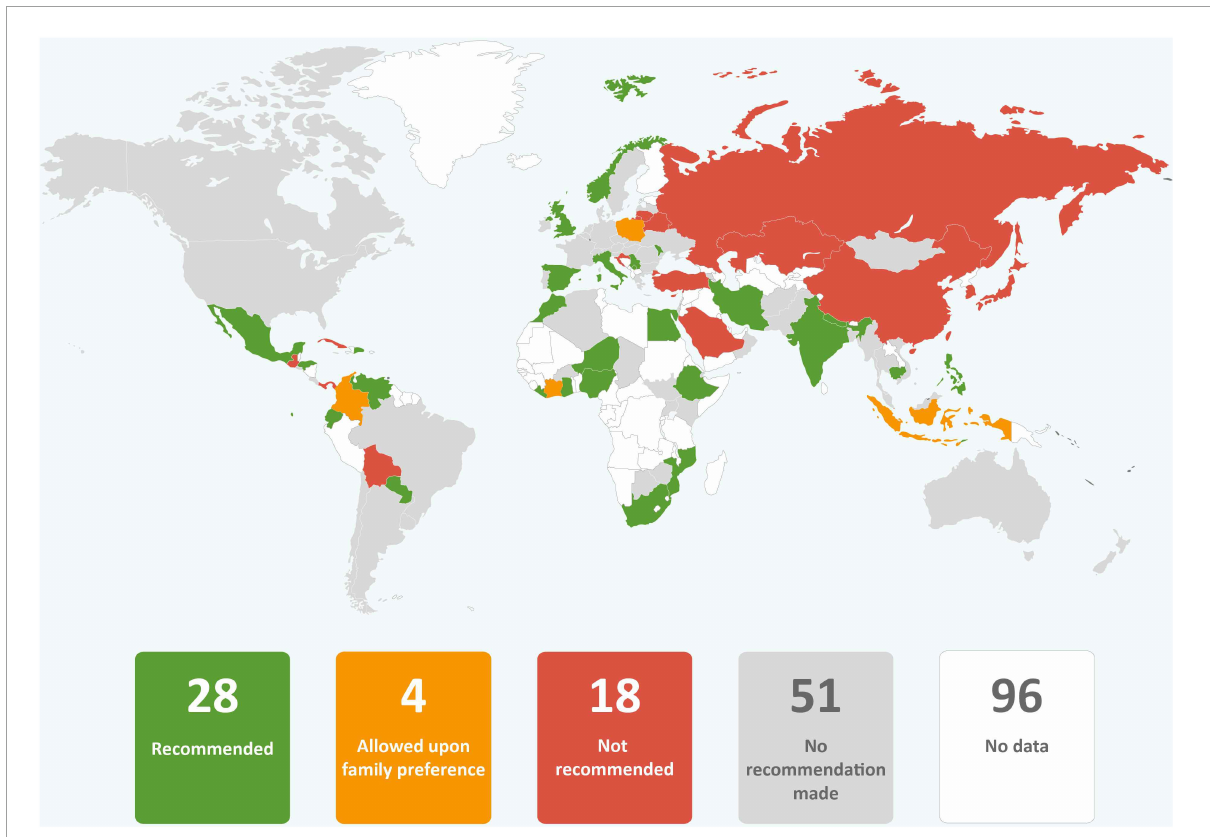
FIGURE3 Global distribution of recommendations on early initiation of breastfeeding for infants of mothers with COVID-19 (data from 101